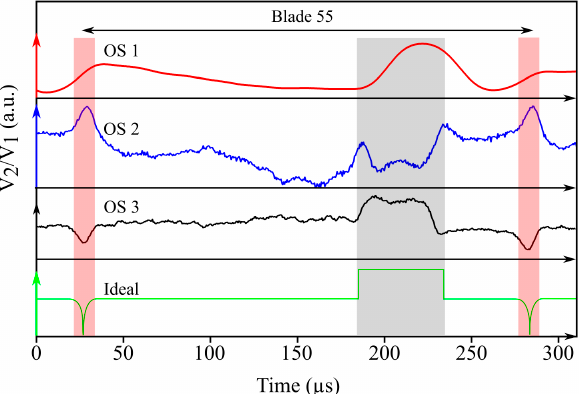
Figure 5. Comparison of sensors signals for a typical blade. The lower curve represents the ideal signal response. The datum and inter-blade spacing are highlighted with grey and red-shaded areas, respectively.